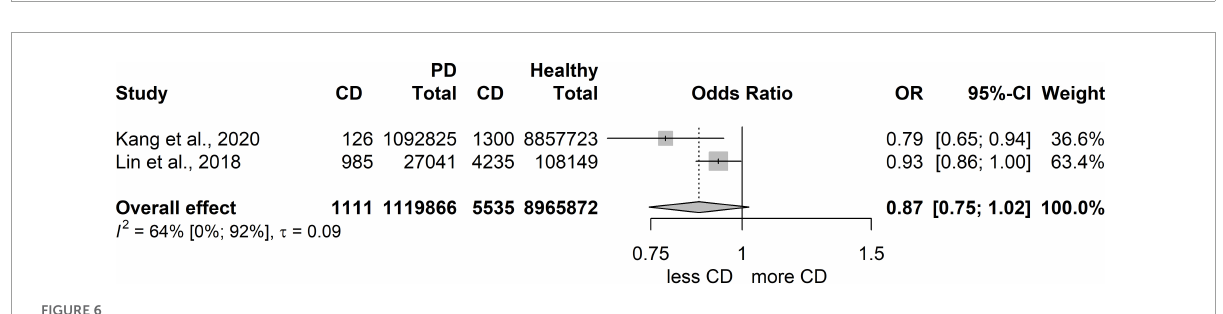
FIGURE6 Risk for developing Crohn’s disease (CD) in patients with